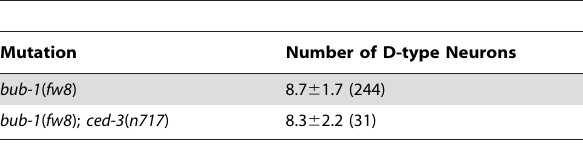
Figure 2. Sequence Comparison of BUB-1 and Rescue of fw8 . (A) Alignment of C. elegans BUB-1 (http://www.wormbase.org/db/seq/ protein?name=WP%3ACE06251;class=Protein), S. cerevisiae BUB1 (http://db.yeastgenome.org/cgi-bin/protein/protein?sgdid=S000003 420), and H. sapiens BUB1A (http://www.ensembl.org/Homo_sapiens/protview? peptide= ENSP00000 302530). The conserved protein kinase domain of C. elegans BUB-1 is 29% identical with S. cerevisiae BUB1, and 31% identical with H. sapiens BUB1A. The protein sequences were obtained from wormbase, Ensembl, and SGD. BLASTS of two sequences were done using NCBI BLASTP. Multiple sequence alignment was done using ClustalW on the EMBL-EBI website (http://www.ebi.ac.uk/clustalw/index.html), and the shade was added by using BOXSHADE 3.21 (http://www.ch.embnet.org/ software/BOX_form.html). The shade shows the conserved protein sequence. The black line indicates the deletion region of tm2815 . (B) P unc- 119::bub-1 partially rescued the reduced D-type neuron defect of fw8 . Y axis shows the D-type neuron numbers. The bars represent standard deviation (the t test compared to control fw8 ; juIs76 : P , 0.001). Table 3. Number of D Type Motor Neuron in bub-1 ( fw8 ); ced- 3 ( n717 ) Mutants.